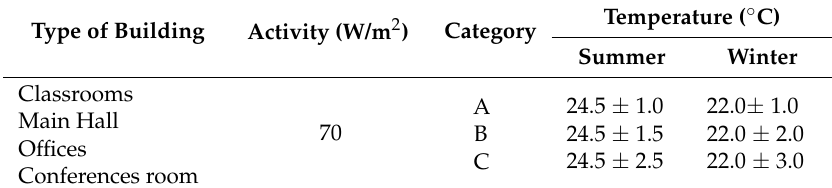
Table 6. The range of recommended air temperatures for offices and classrooms, according to ISO